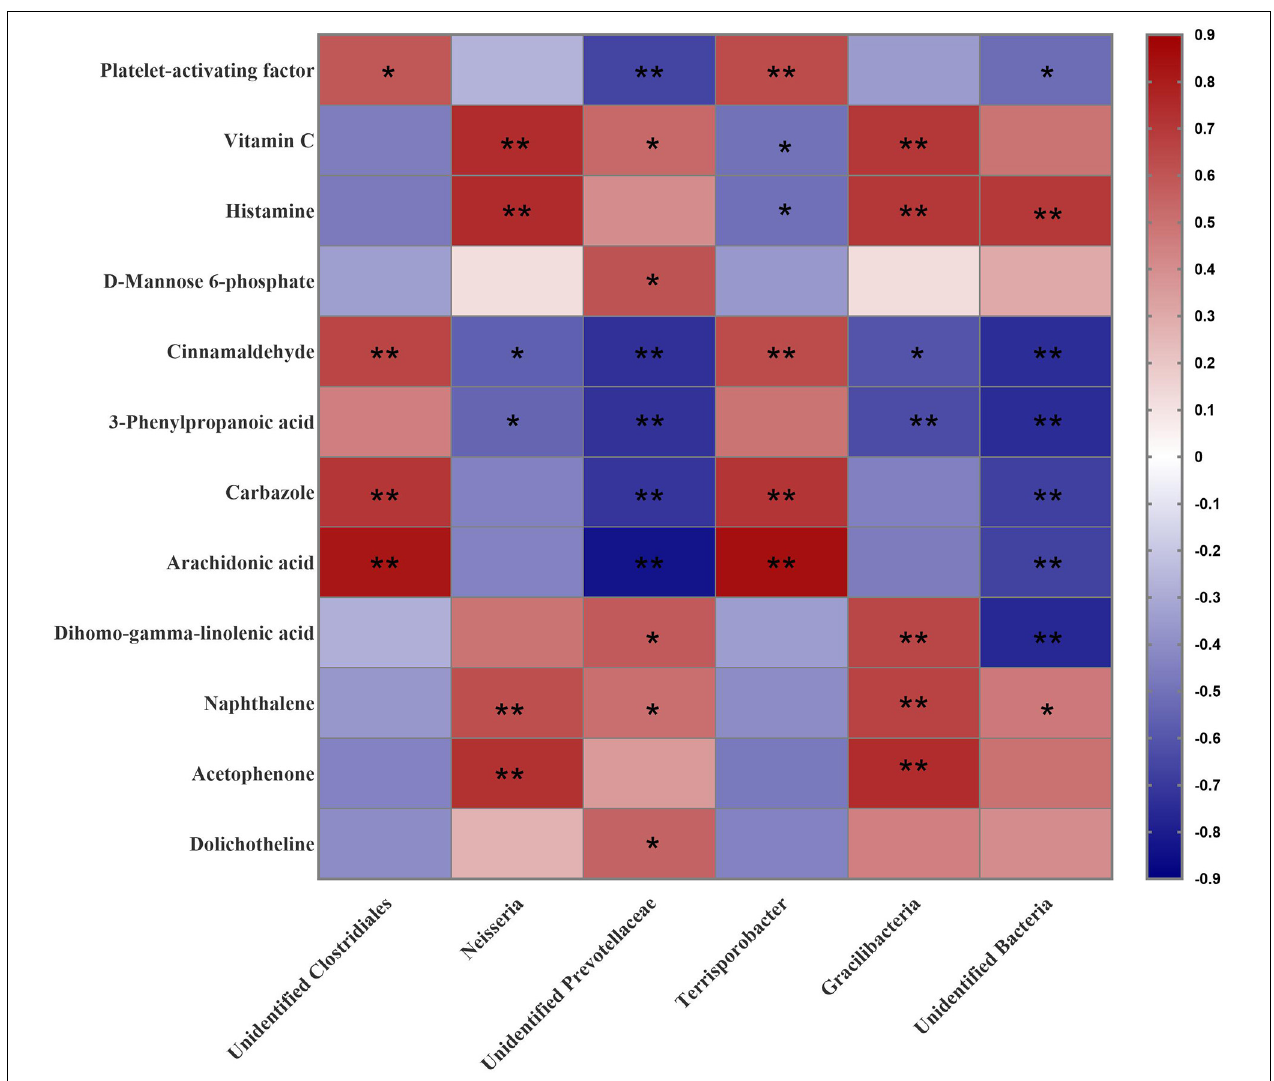
FIGURE 7 | Correlation analysis between the predominant microbial community at genus level (relative abundance) and differentially abundant metabolites in the colonic content of gilts induced by different dietary protein levels. * P < 0.05; ** P <